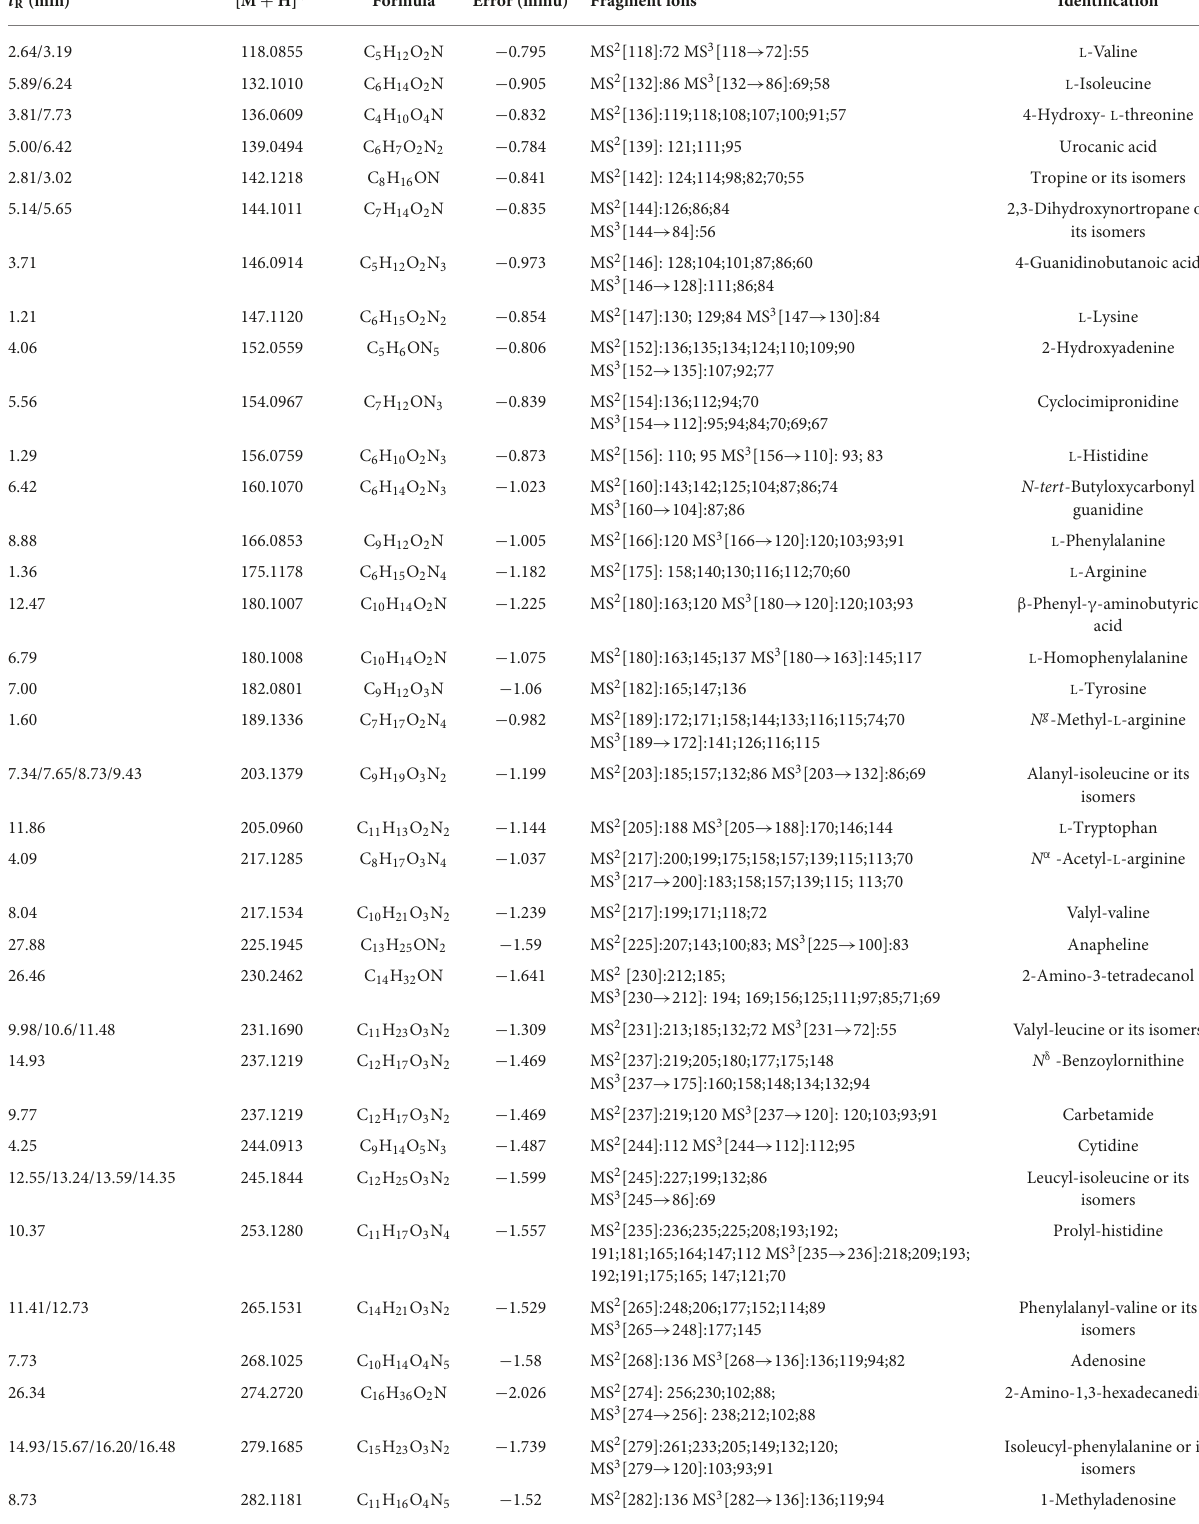
TABLE 1 Identification of main chemical compounds from Dendrobium